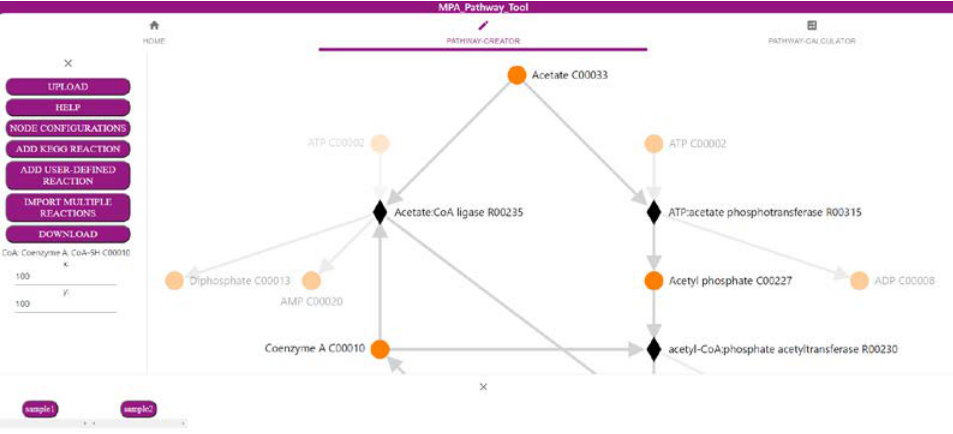
Figure 1. Screenshot of the ‘Pathway-Creator’ of the MPA_Pathway_Tool (details in Section 2.1).